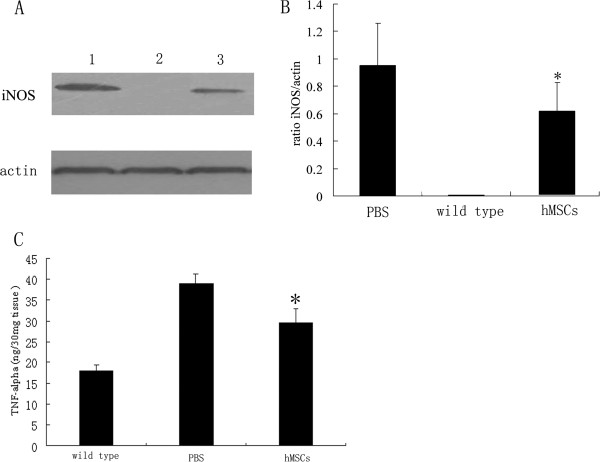
Inhibiting TNFα and iNOS production by human marrow stromal cell treatment in SOD1 transgenic mice. Lumbar spinal cord tissues from wild-type mice, PBS-treated and human marrow stromal cell (hMSC)-treated transgenic mice at the age of 11 weeks are assayed for inducible nitric oxide synthase (iNOS) protein expression by Immunoblot and TNFα level by ELISA. (A) Representative immunoblots for iNOS and β-actin of the lumbar spinal cord from PBS-treated transgenic mice (1), wild-type mice (2) and hMSC-treated transgenic mice (3). (B) Quantitative evaluation through optical densitometry of iNOS blot and relation to β-actin blot. The levels of iNOS in Cu/Zn superoxide dismutase 1 (SOD1) transgenic mice receiving hMSC transplantation were significantly reduced compared with those in vehicle-treated mice (*P <0.01 versus PBS alone). (C) Intrathecally injected hMSCs significantly decreased the spinal cord TNFα level in SOD1 transgenic mice (*P <0.01 versus PBS alone).